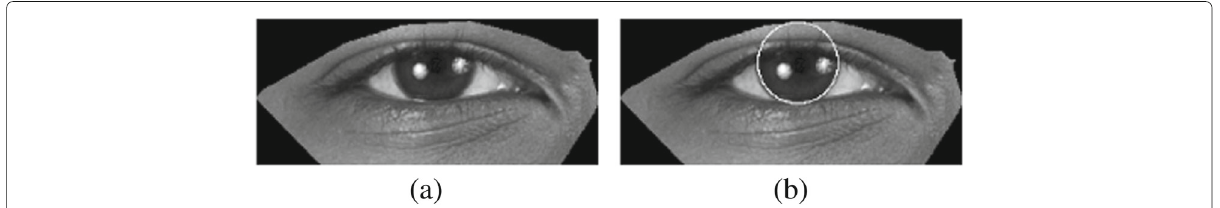
Fig. 3 Coarse iris segmentation. Original extracted eye image in greyscale ( a ) and iris/sclera boundary found by Daugman’s algorithm ( b )